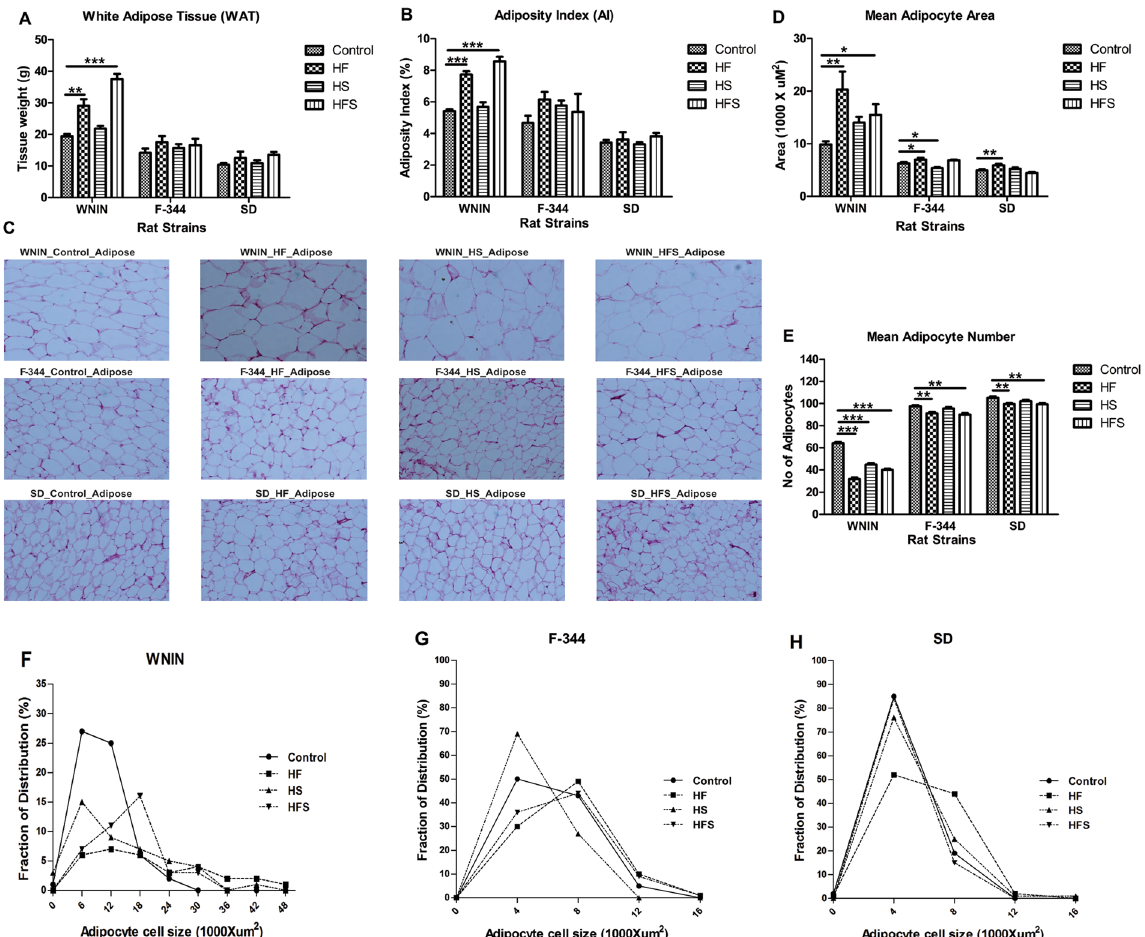
Figure 2. Effect of high calorie environment towards visceral adiposity and adipocyte histology in genetically different rat strains. After the completion of feeding experiment, rats (WNIN, F-344 and SD) were sacrificed and assessed visceral adiposity and adipocyte histology. ( A ) Dissection weights of white adipose tissue (WAT). ( B ) Adiposity index was calculated to measure central adiposity. ( C ) Hematoxylin-Eosin (H&E) staining was performed to determine the morphology of retro adipose tissue. ( D & E ) Mean adipocyte area and adipocyte number was calculated in retro adipose tissue. ( F – H ) Fraction of distribution of adipocytes in retroadipose tissue. Diets: control; HF, high fat; HS, high sucrose; HFS, high fat sucrose. * P < 0.05; ** P < 0.01; *** P < 0.001 statistically significance compared to their respective controls s. Groups were compared using one way